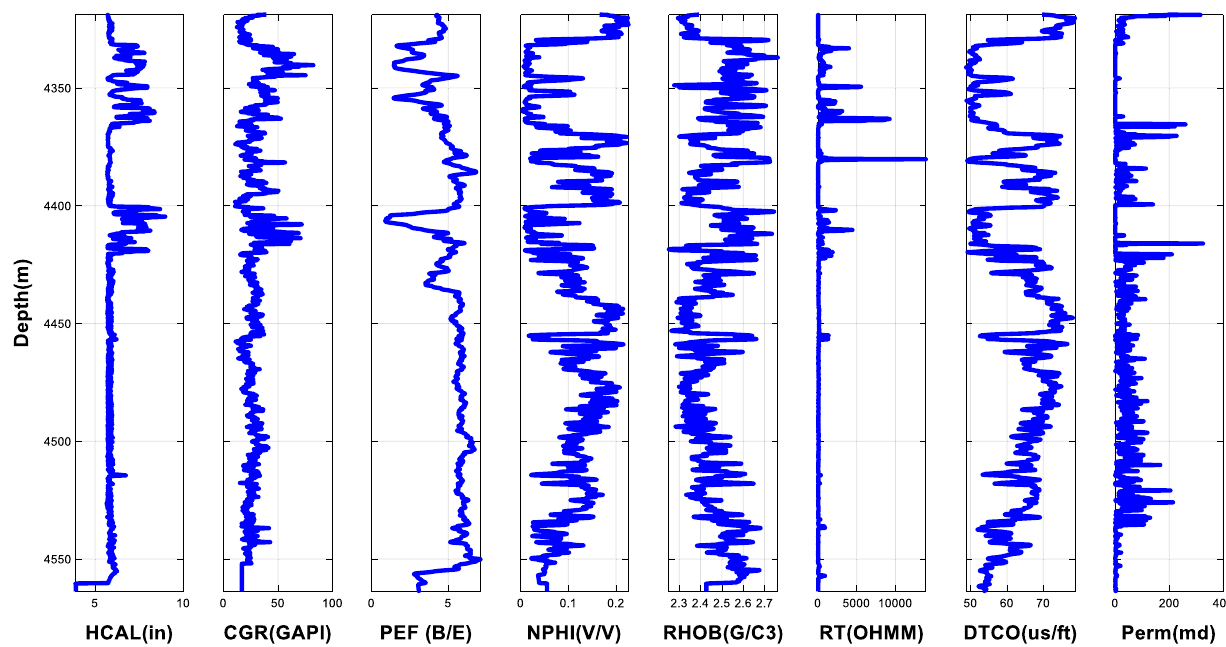
Fig. 3 Variations of petrophysical log readings and permeability over the studied depth interval at the studied